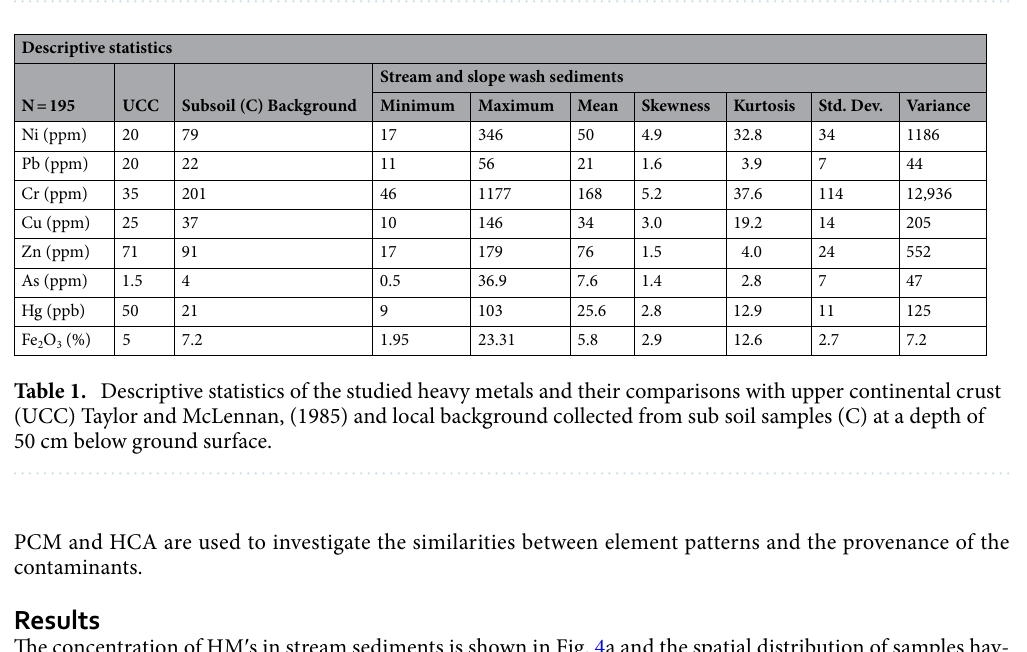
Figure 3. Land-use land-cover map of the study area, Source: Bhat et al., 2021. Map prepared using Microsoft Paint and Origin-Pro 2016 software (URL link: http:// www. origi nlab. com).